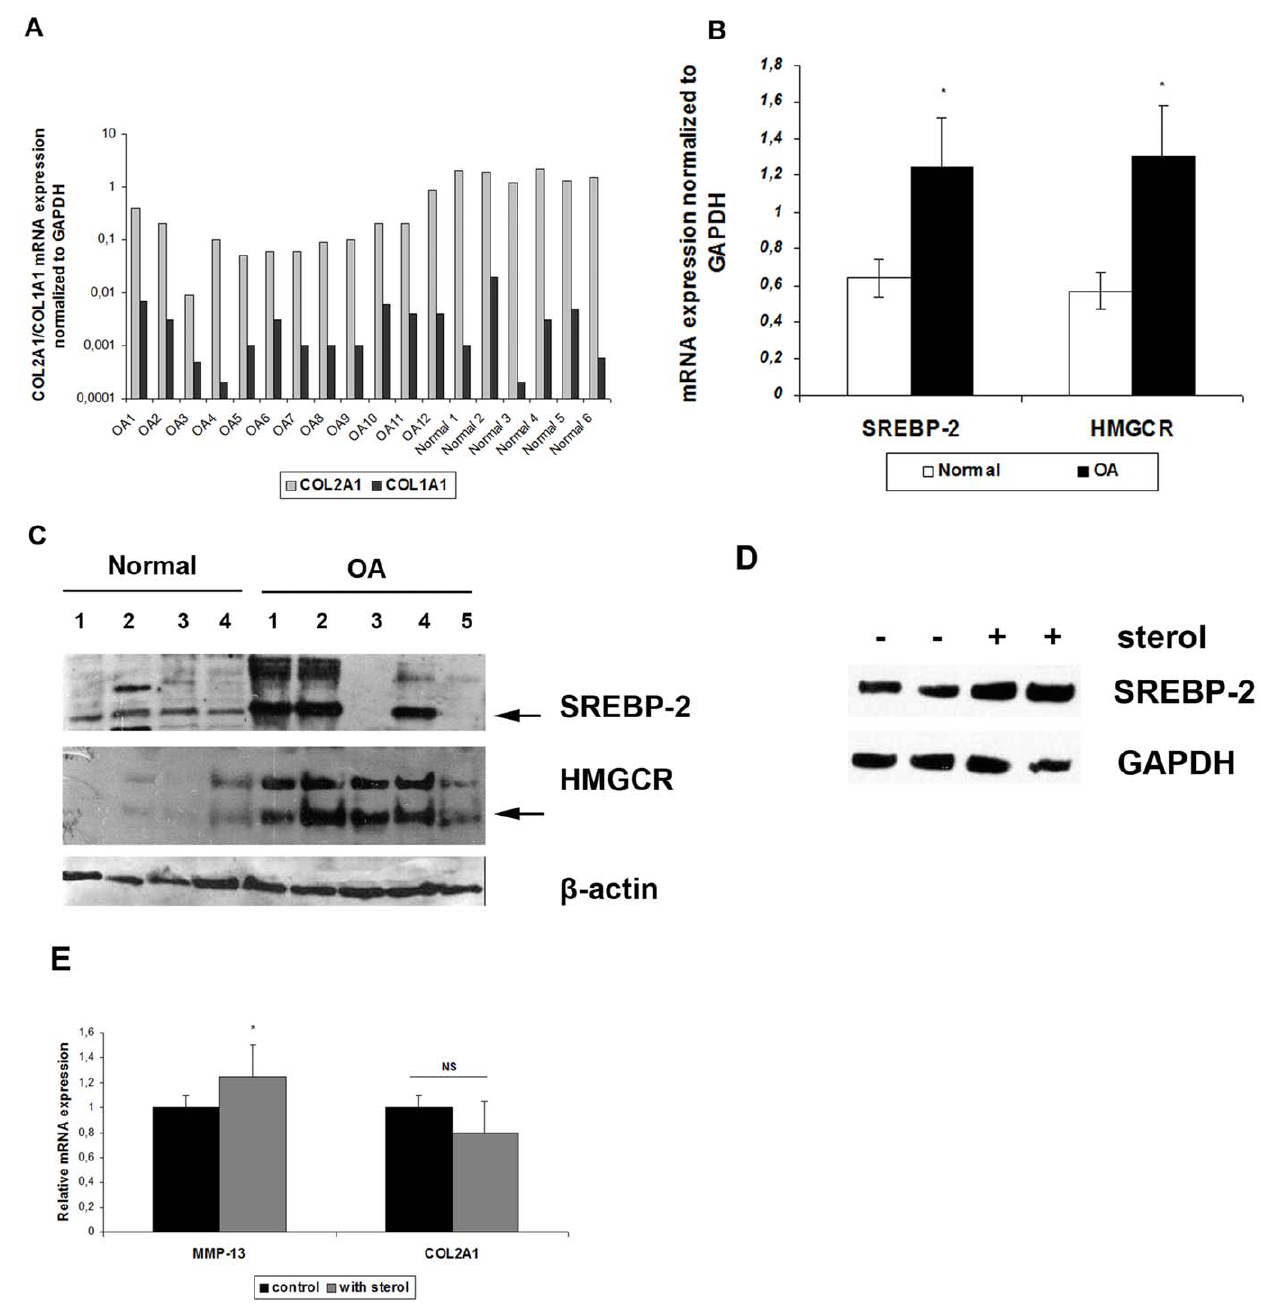
Figure 1. SREBP-2 and HMGCR mRNA and protein expression in normal and osteoarthritic chondrocytes. ( A ) COL2A1 and COL1A1 ratio was screened for the verification of chondrocytes’ phenotype in cultures ( B ) SREBP-2 and HMGCR mRNA expression in normal and osteoarthritic chondrocytes. GAPDH was used for normalization of the Real Time PCR data. All experiments were performed in duplicate. *p , 0.05 ( C ) Representative film showing SREBP-2 and HMGCR protein expression evaluated by Western blot analysis in normal and osteoarthritic chondrocytes. b -actin was used as loading control. ( D ) Representative film showing SREBP-2 protein expression evaluated by Western blot analysis in osteoarthritic chondrocytes treated with 25 m M of 25-hydroxycholesterol. GAPDH was used as loading control. ( E ) MMP-13 and COL2A1 mRNA expression in osteoarthritic chondrocytes treated with 25 m M of 25-hydroxycholesterol. GAPDH was used for normalization of the Real Time PCR data. All experiments were performed in duplicate. *p , 0.05, NS: non significant. doi:10.1371/journal.pone.0035753.g001 treated cells (Figure 5C) (p , 0.001) indicating an at least partial SREBP-2 1784 G/C SNP Heterozygosity is Associated with reversal of the osteoarthritic phenotype by integrin blockage. Increased SREBP-2 Protein Levels SREBP-2 genotypes were evaluated in OA and normal cartilage samples. We found that 8/12 OA samples had the heterozygous